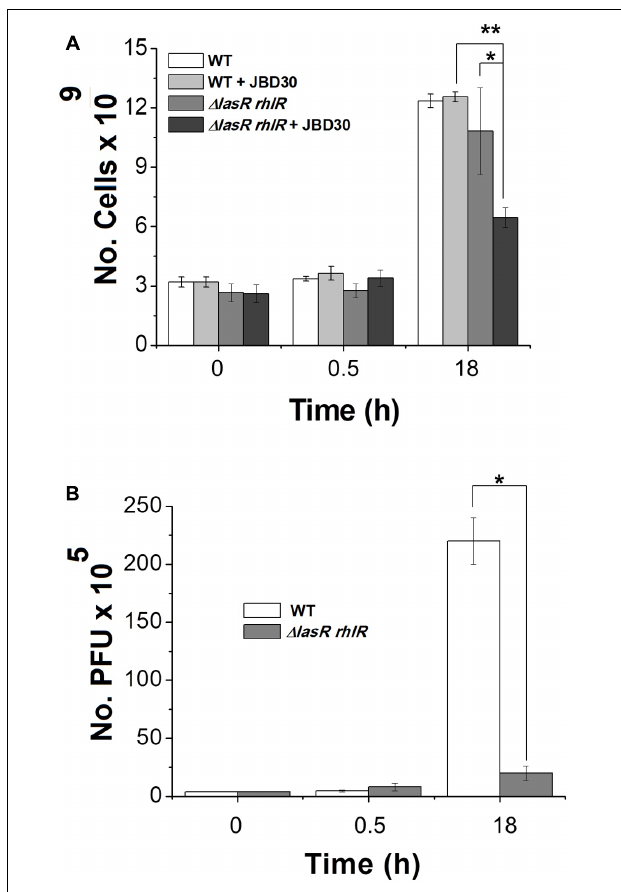
FIGURE 1 | Bacteriophage JBD30 replicates preferentially in the wild-type strain but had a higher killing effect in the QS mutant. Phage JBD30 (2 × 10 6 pfu) was added to LB cultures of PA14 wild-type and lasR rhlR mutant (at OD 600 nm ∼ 2.2) and the number of cells (A) and phage (B) were determined at the initial time, and after 0.5 and 18 h after the phage addition. Experiments were done in triplicate and the averages are shown. The cfu of the mutant in the presence of JBD30 at 18 h is significantly lower than the cfu of the mutant without phage ( ∗ ), as well as the cfu of the mutant in the presence of JBD30 at 18 h, relative to the cfu of the wild-type in the presence of the phage ( ∗∗ ) P < 0.05, in a two-tailed Student’s t -test, while the number of phages produced at 18 in the wild-type strain is significantly higher than for the mutant P < 0.05, in a two-tailed t -test.